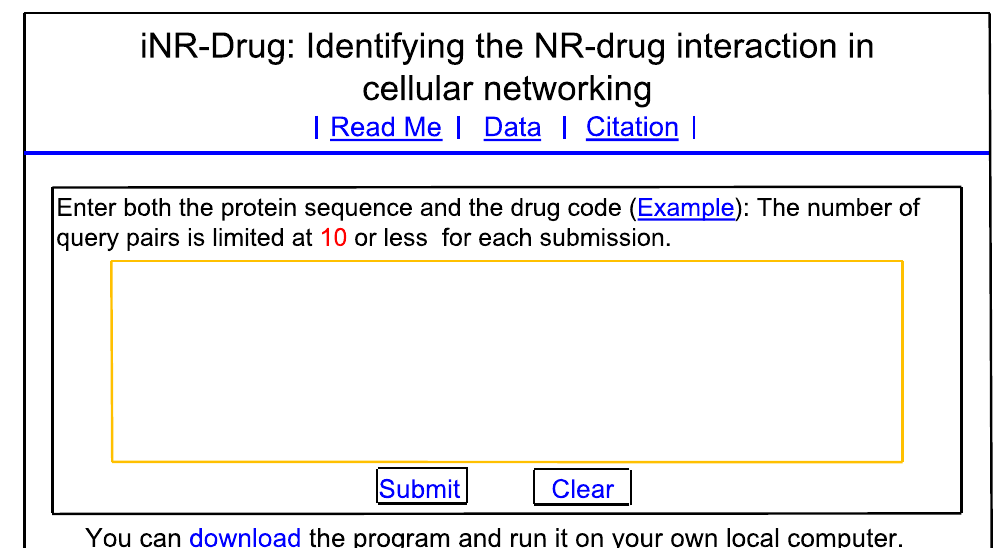
Figure 4. A semi-screenshot to show the top page of the iNR-Drug web-server. Its website address is at